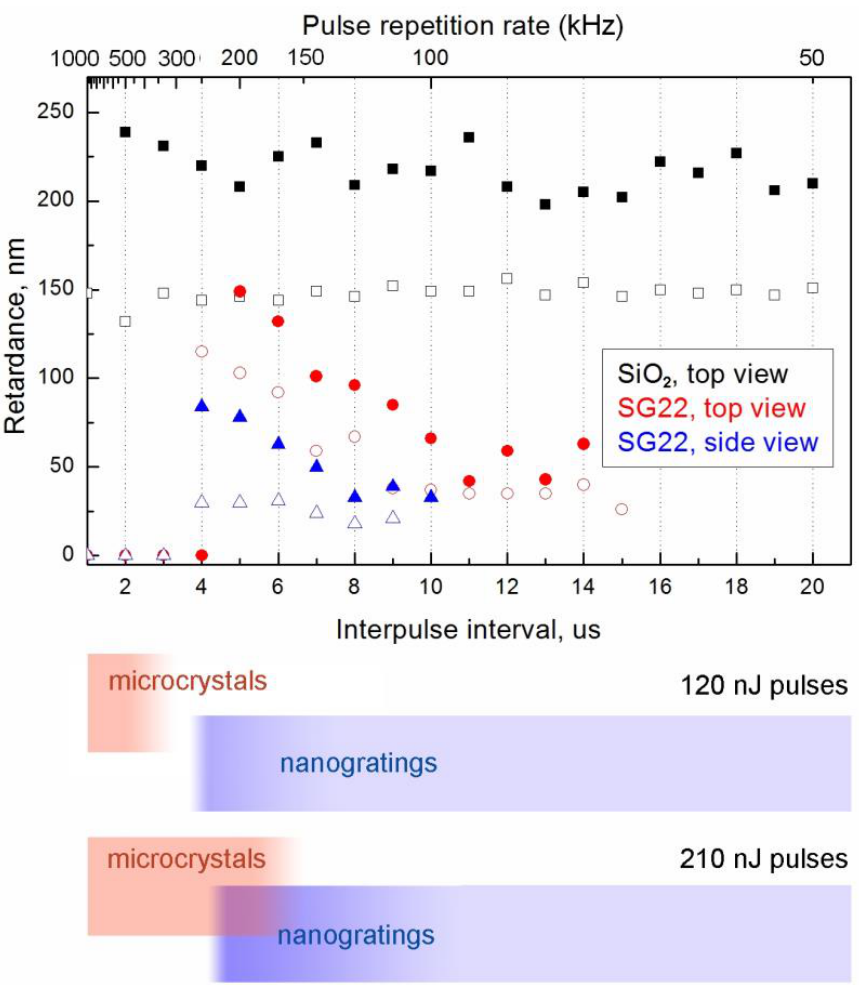
Figure 4. Retardance of nanogratings written by 10 6 pulses per dot in SG22 glass at 1.2 ps pulse duration, and 120 nJ ( ○ —top view, △ —side view) and 210 nJ ( ● —top view, ▲ —side view) pulse energy and in SiO 2 glass (top view) at 120 nJ ( □ ) and 210 nJ ( ∎ ) pulse energy as a function of PRR ( top ). Diagram of the nanograting formation and crystallization at an indicated pulse energy and the same PRR scale ( bottom ).